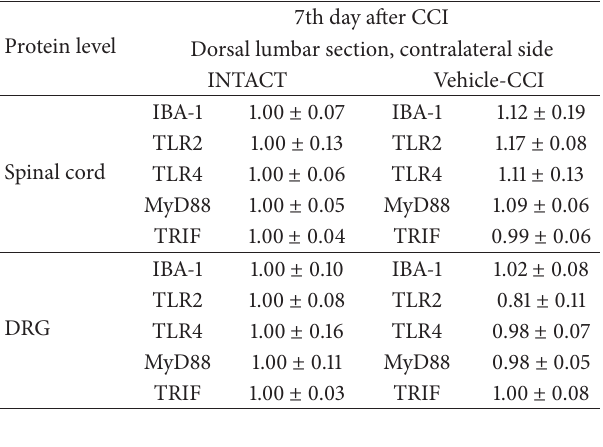
Table 1: Western blot analysis of IBA-1, TLR2, TLR4, MyD88, and TRIF protein levels in the contralateral dorsal lumbar spinal cord and DRG tissue on 7th day after chronic constriction injury (CCI) in rats. The results are not statistically significant and are presented as the mean ± SEM of 4–7 samples per group (see also Figure 4).